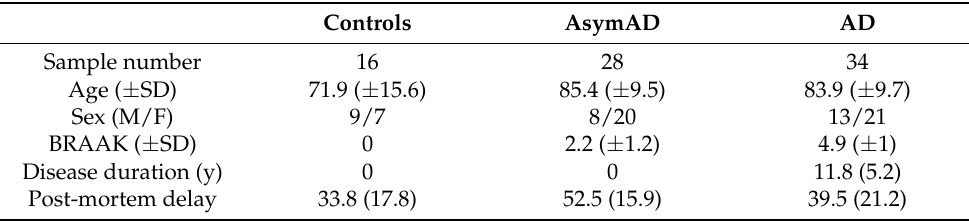
Table 1. Characteristics of the participants. Controls AsymAD